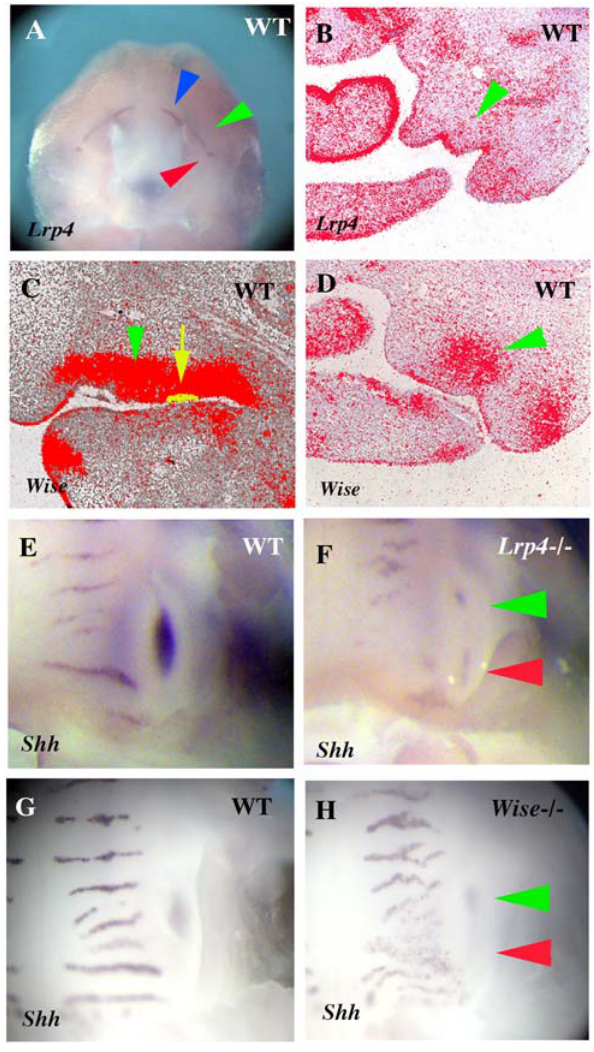
Figure 6. Gene expression in diastema and molar region. (A) Lrp4 expression in incisor teeth (blue arrowhead), in molar teeth (red arrowhead) and in the diastema (green arrowhead). (B) Sections of the diastema region showed Lrp4 expression in epithelium (arrowhead). (C, D) Wise expression in mesenchyme of diastema region (green arrowheads in C and D). Tooth epithelium was comfirmed by Shh expression in adjacent specimen (yellow domain pointed by arrow in C). (E–H) Ectopic Shh expression in diastema (green arrowhead in F and H). Reduced intensity of Shh expression in molar tooth germ (red arrowhead in F and H). Whole mount (A, E–H) and radioactive in situ hybridization (B–D) showing Lrp4 (A, B), Wise (C, D) and Shh (E–H) expression at E12.5 (A–D) and E14.5 (E–H) in wild-type (A–E and G), Lrp4 mutants (F) and Wise mutants (H). Sagittal section (C) and frontal sections (B and